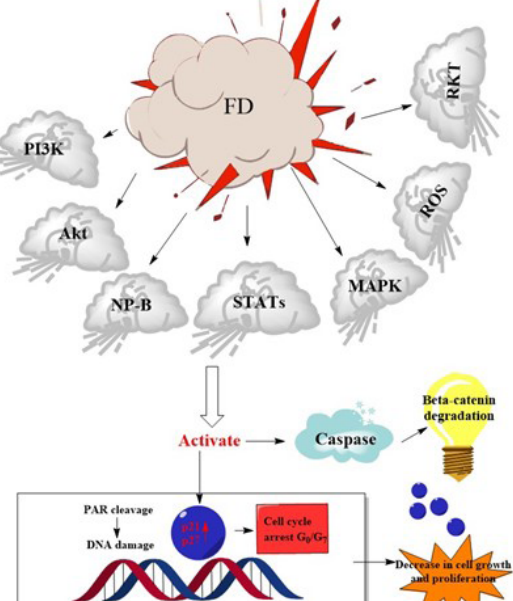
Figure 7. Possible mechanisms of action of F. deltoidea crude extract or pure compounds on cancer cells. STATs: Signal transducer and activator of transcription; RKT: Receptor tyrosine kinases; PAR: Protease-activated receptor; G